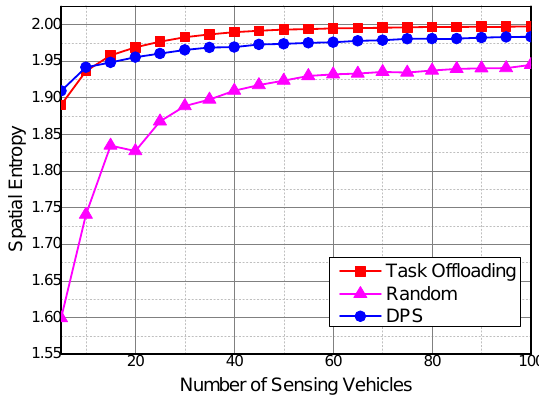
Figure 8. Spatial entropy with different numbers of sensing